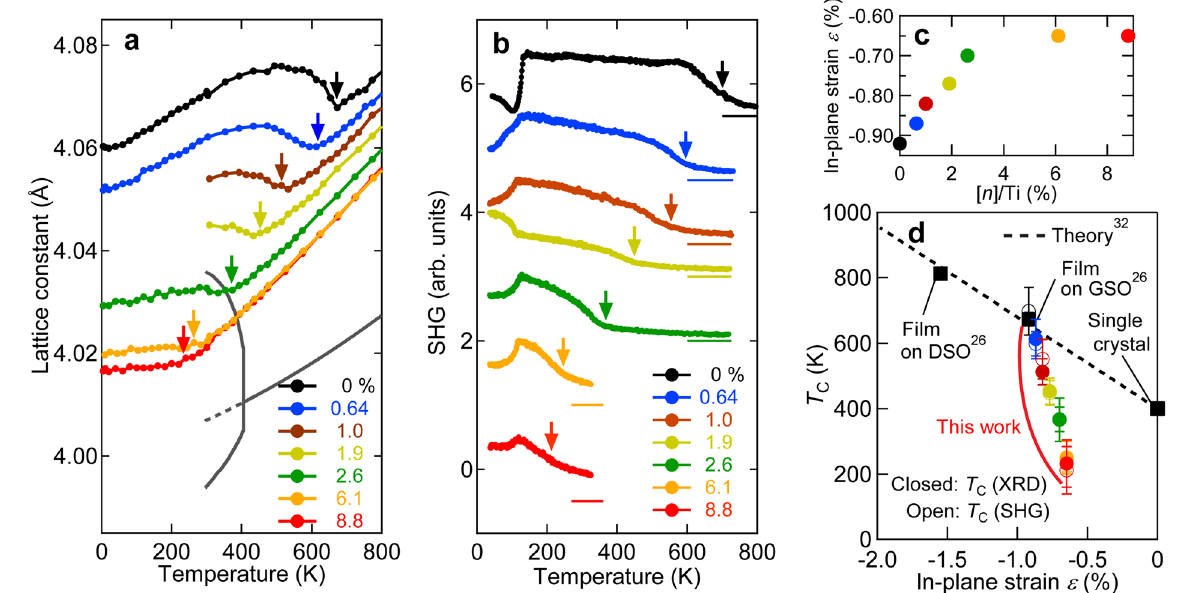
Figure 2. Polar transitions of La-doped BaTiO 3 films. ( a ) Temperature dependence of the c -axis lattice constant for non-doped BTO and La-BTO films grown on GSO (110) together with that of lattice constants for the cubic and tetragonal phases of BTO single crystal 26, 27 . The dotted curve denotes the extrapolated lattice constant of BTO single crystals in the cubic phase. ( b ) Temperature dependence of the optical SHG intensity of the films. ( c ) La doping ([ n ]/Ti) dependence of in-plane strain ε . ( d ) Non-polar to polar transition temperature T C as a function of the in-plane strain ε of non-doped and La-doped BTO films on GSO, of non-doped BTO films on GSO and of DSO 26 with a theoretical line based on the phase-field simulation 32